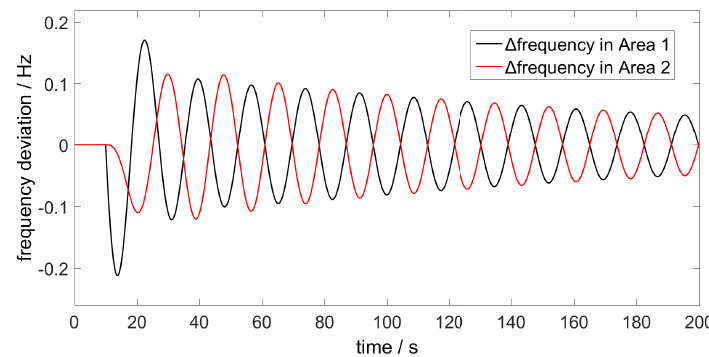
Figure 3. Frequency deviation of the open-loop LFC